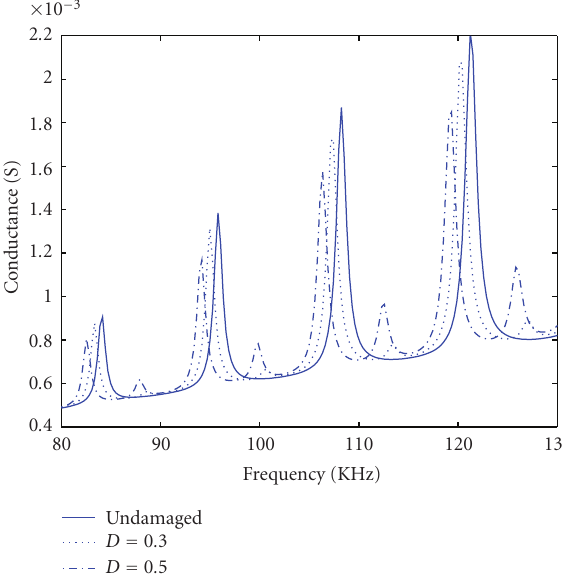
Figure 6: EM admittance signatures for various damage growth.